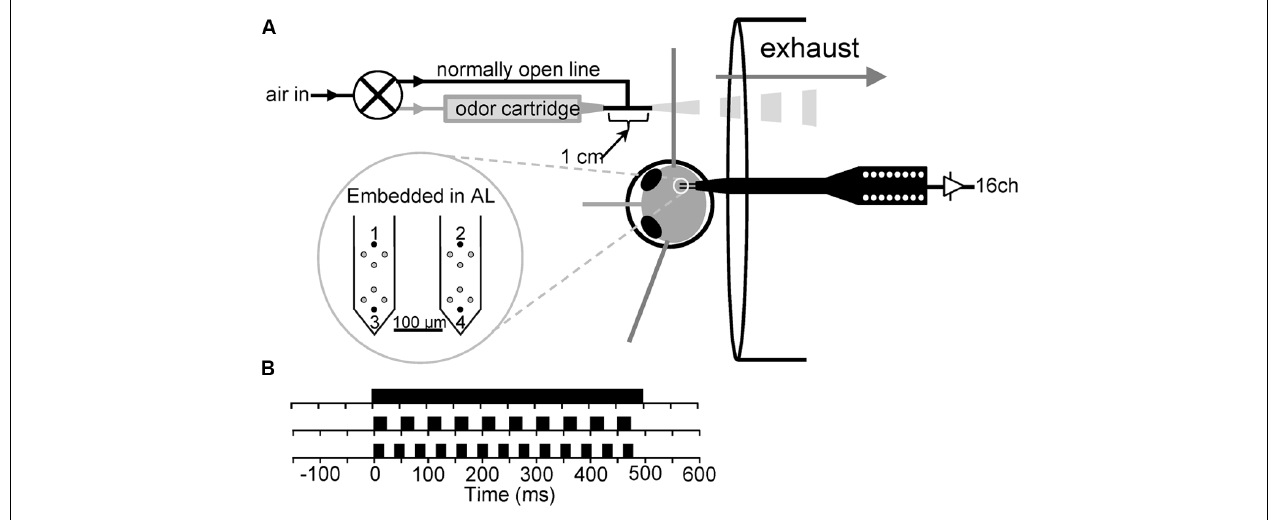
FIGURE 1 | (A) Schematic of experimental preparation. (B) Schematic of the 500 ms continuous stimulus (top) and the 500 ms, 20 Hz (middle) and 500 ms, 25 Hz (bottom) pulse trains. Note that a 50% on/off duty cycle was used for both pulse trains.